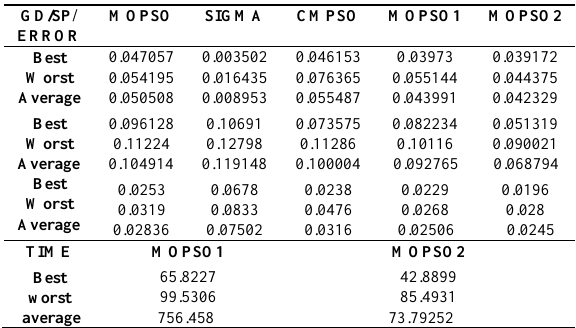
Table 4: GD/SP/ERROR/TIME result for third function. GD/SP/ ERROR